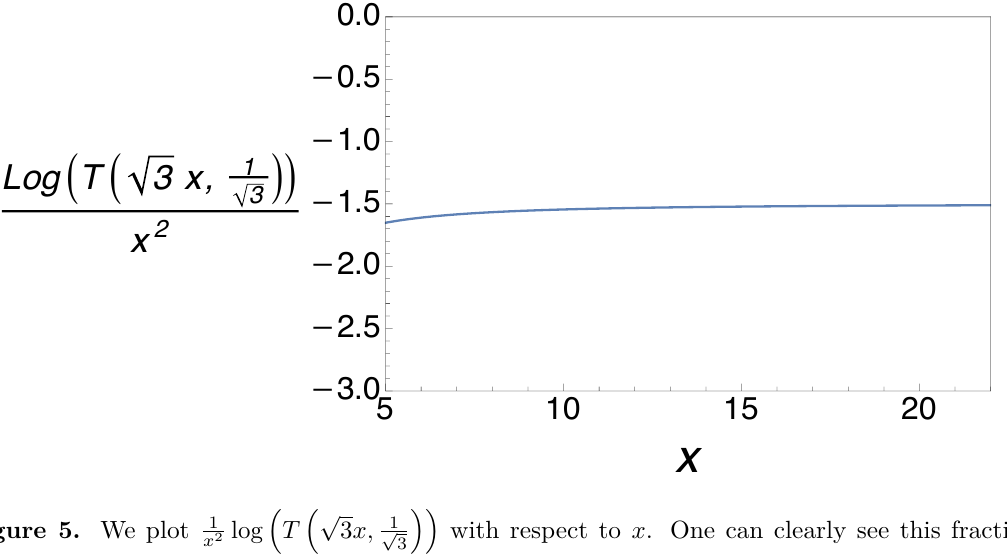
(cid:16) √ (cid:17) 3 x, 1 √ ’ e − c 0 x 2 in 3